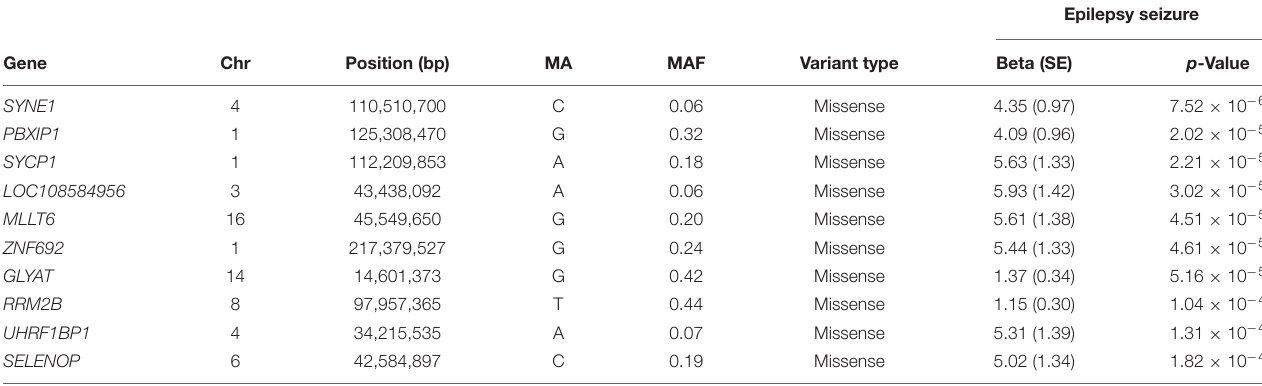
TABLE 2 | Top ten genome-wide association results for protein-altering SNPs.